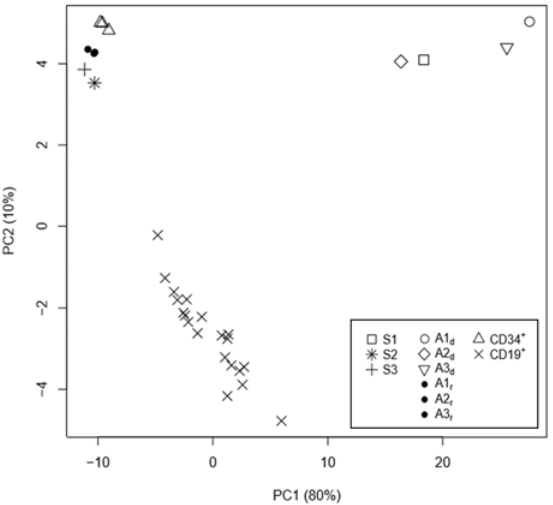
Figure 3. Principal component analysis (PCA) of the DNA methylation values for the “top” 5139 CpG loci among the twin samples (S1, S2, and S3), the three diagnosis–remission-paired samples (couples Ai d –Ai r , i = 1, 2, 3), and the CD34 + and CD19 + cells. Whole transcriptome profiles were determined for the four diagnosis–remission samples through mRNA sequencing. Unsupervised hierarchical clustering revealed ex- pression profiles distinguishing the diagnosis samples from the remission samples (Sup- plementary Figure S2). Specifically, we identified 4376 differentially expressed genes in the diagnosis versus remission samples (1.44 < |Log2FoldChange (FC)| < 12.34; 6.03 × 10 − 42 < PFDR < 0.05; Supplementary Table S4). The downregulated (2536) and upregulated (1840) genes at diagnosis included genes involved in the development or functioning of the immune system, response to stimuli, and characterization of the immune cell sub- types. The top 20 significant overlaps computed for both the down- and upregulated genes are provided in Supplementary Table S5A,B. Among the 4376 genes significantly up- and downregulated at diagnosis, 363 (8.3%) overlapped those harboring the 5139 differentially methylated CpG sites in both of the twin samples and in the three paired diagnosis–remission samples. We correlated the CpG methylation changes and expression levels. Thirty-two out of 363 genes harbored at least 3 CpGs (134 CpG sites in total; Supplementary Table S6), with rho ≥ |0.7|. Notably, in the healthy parents (S4 and S5), the methylation profiles of these 134 CpG sites were compa- rable to those of an internal control group composed of healthy adult subjects (data not shown), which excluded possible deregulated patterns potentially transmitted from par- ents to their daughters. GSEA analysis performed on the 32 genes whose expression levels correlated with the DNA methylation profiles showed significant overrepresentation of genes upregu- lated in embryonic stem cells from TCEB3 knock-out mice, cell–cell junctions, and cell movements (FDR q -value < 9.36 × 10 − 3 ; Supplementary Table S7). The differentially meth- ylated CpG sites corresponding to these 32 genes were all hypermethylated at diagnosis, and 65% of them were within the gene promoter. Negative correlations were observed between methylation and gene expression for all CpGs except for those within the MACROD2 gene and one CpG in the PLEKHG5 3 ′ UTR. The expression levels of five genes showed the strongest significance between the affected and healthy subjects (PFDR < 10 − 6 ) as well as a correlation higher than 80% with corresponding DNA methylation changes. In particular, the methylation levels of 11 CpG sites located within 1500bp or 200bp up- stream of the transcription starting site (TSS) of the RAB32 gene were inversely correlated with their expression levels (log2FC = − 4.42; PFDR = 4.08 × 10 − 8 ; − 0.97 ≤ rho ≤ − 0.84; Pcorr ≤ 0.04; Figure 4).